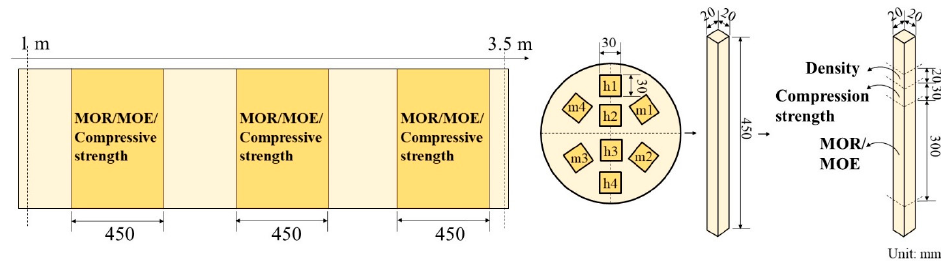
Figure 1. A diagram of the physical and mechanical properties of a prepared wood specimen.